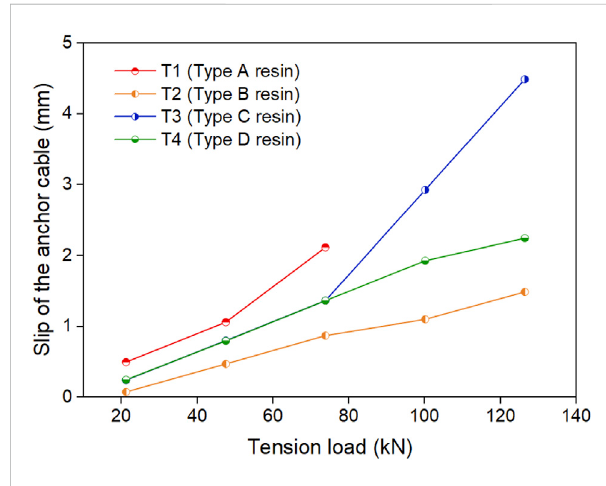
FIGURE 9 Slip – load curves of TSAS with different